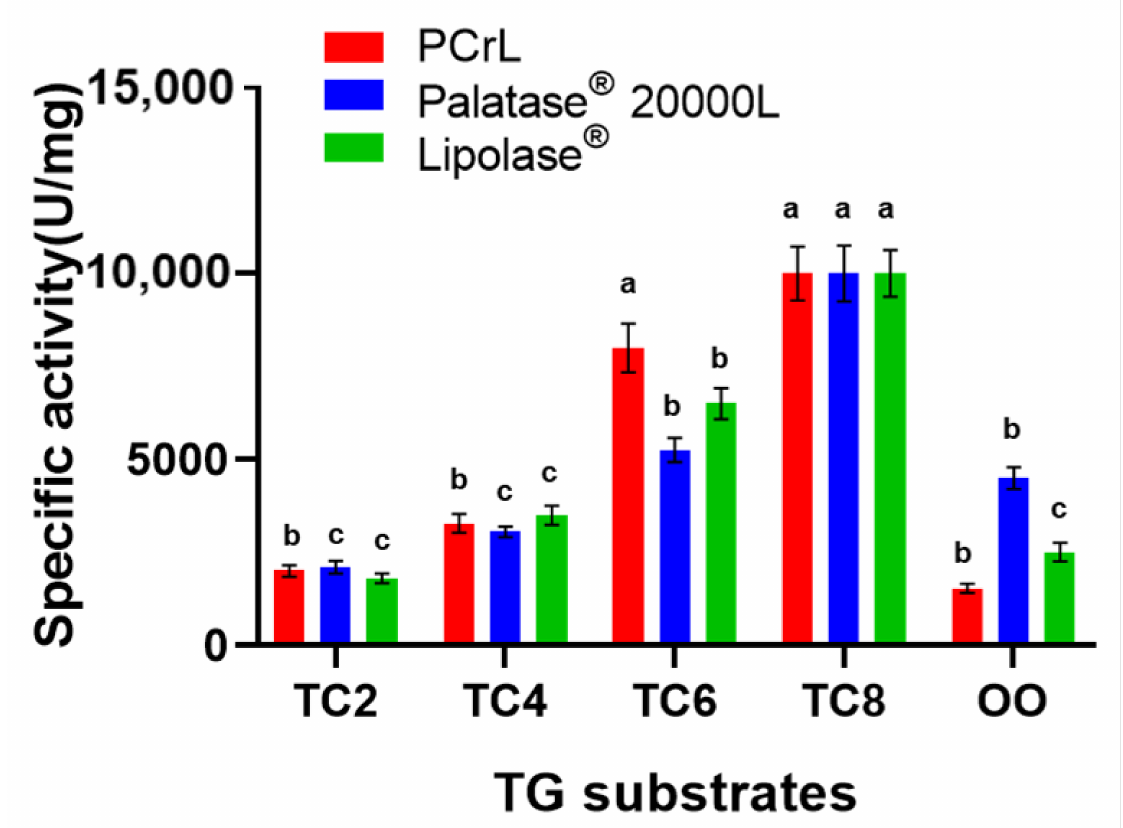
Figure 6. Substrate specificity of PCrL. Lipase activity was measured using TC2, TC4, TC6, TC8, or OO emulsion as the substrate, as described in Section 4 (Section 4.9.3). a–c Means in indicator enzymes with different lowercase letters differed significantly ( p <